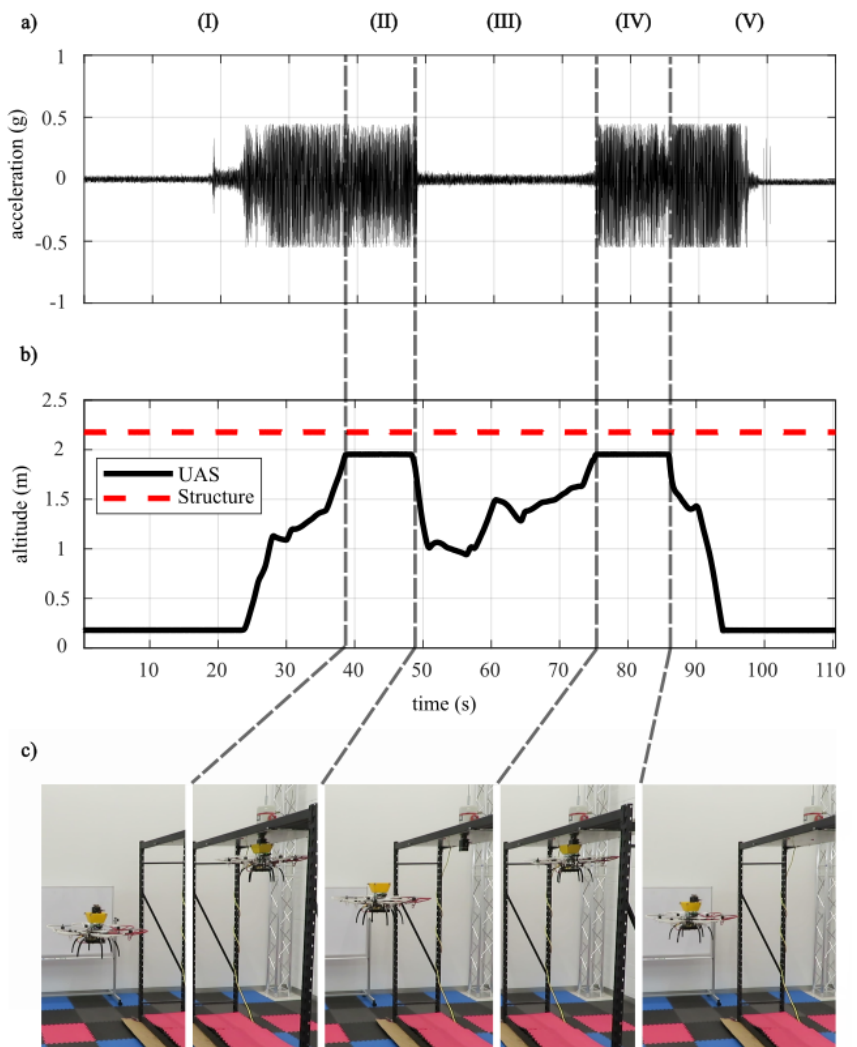
Figure 8. UAS deployment of the sensor package showing ( a ) acceleration of the sensor package, ( b ) displacement of the UAS, and ( c ) photos of the sensor deployment and retrieval